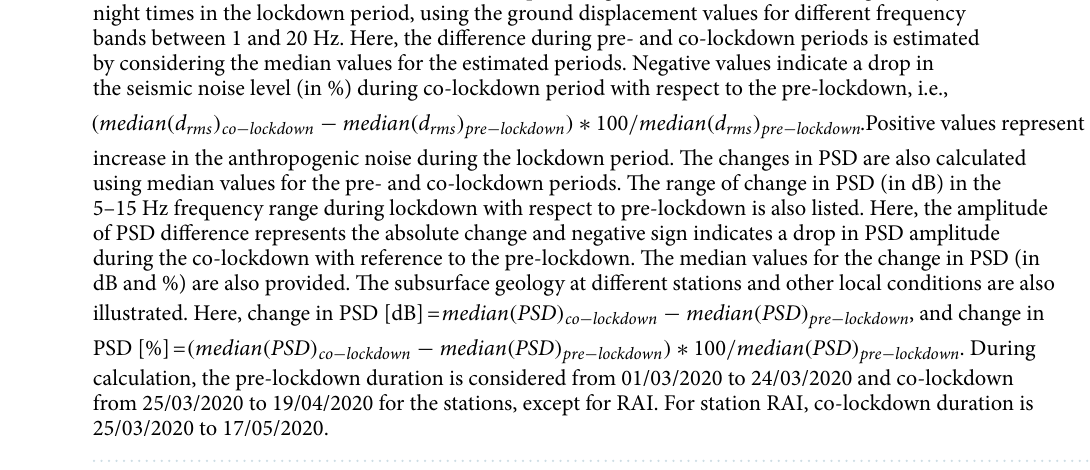
seismic noise is represented in terms of d rms , for each calendar day. The diurnal variations at the stations are also studied in the above mentioned frequency ranges. Matching with the anthropogenic activity in the pre-lockdown period during the day and night times, a similar pattern is observed in hourly variation of seismic noise in differ- ent anthropogenic frequency bands between 1 and 20 Hz, as shown for station RAI (supplementary Figure S9). However, the ground displacement plots in different frequency ranges, for the 12 stations, reveal that the noise amplitude is large in the 1–5 Hz range compared to that in 5–20 Hz, which might be the effect of subsurface geological strata, besides anthropogenic noise sources (Fig. 4 and supplementary Figure S7). Stations installed on sedimentary formations (Quaternary, Tertiary) show noise levels that are ~ 5–25 times larger in comparison to those on hard rocks (Deccan Traps, Proterozoic formations). The seismic noise amplitudes at stations sited on Deccan traps comprising tholeiitic basalts (e.g., MOR, JUN, and LAL) are predominant in the 1–5 Hz and 10–20 Hz range. Large values of seismic background noise correspond well with the predominant frequencies. The predominant frequencies for stations MOR, JUN and LAL are found between 6 and 10 Hz 21 . However, these results are limited up to 10 Hz. This is true for other stations on different geological formations as well. Moreover, the effect of amplification is negligible in hard rock sites compared to that in soft sediments.